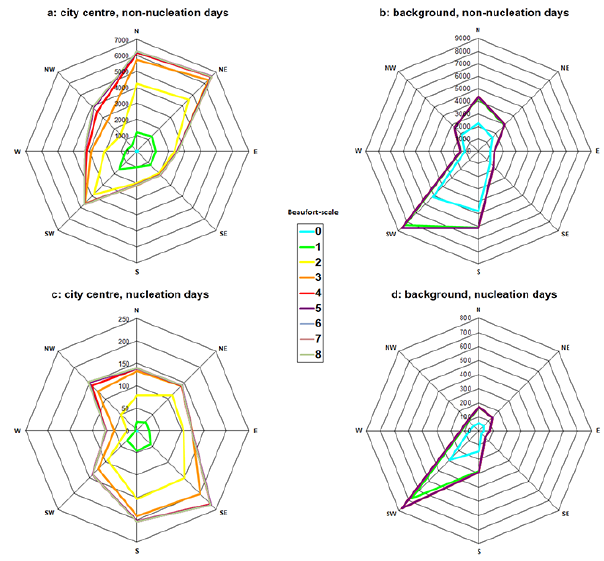
Figure 3. Wind roses for non-nucleation days (a) and for nucleation and growth intervals of class 1A events (c) in the city centre, and for non-nucleation days (b) and for nucleation and growth intervals of class 1A events (d) in the near-city